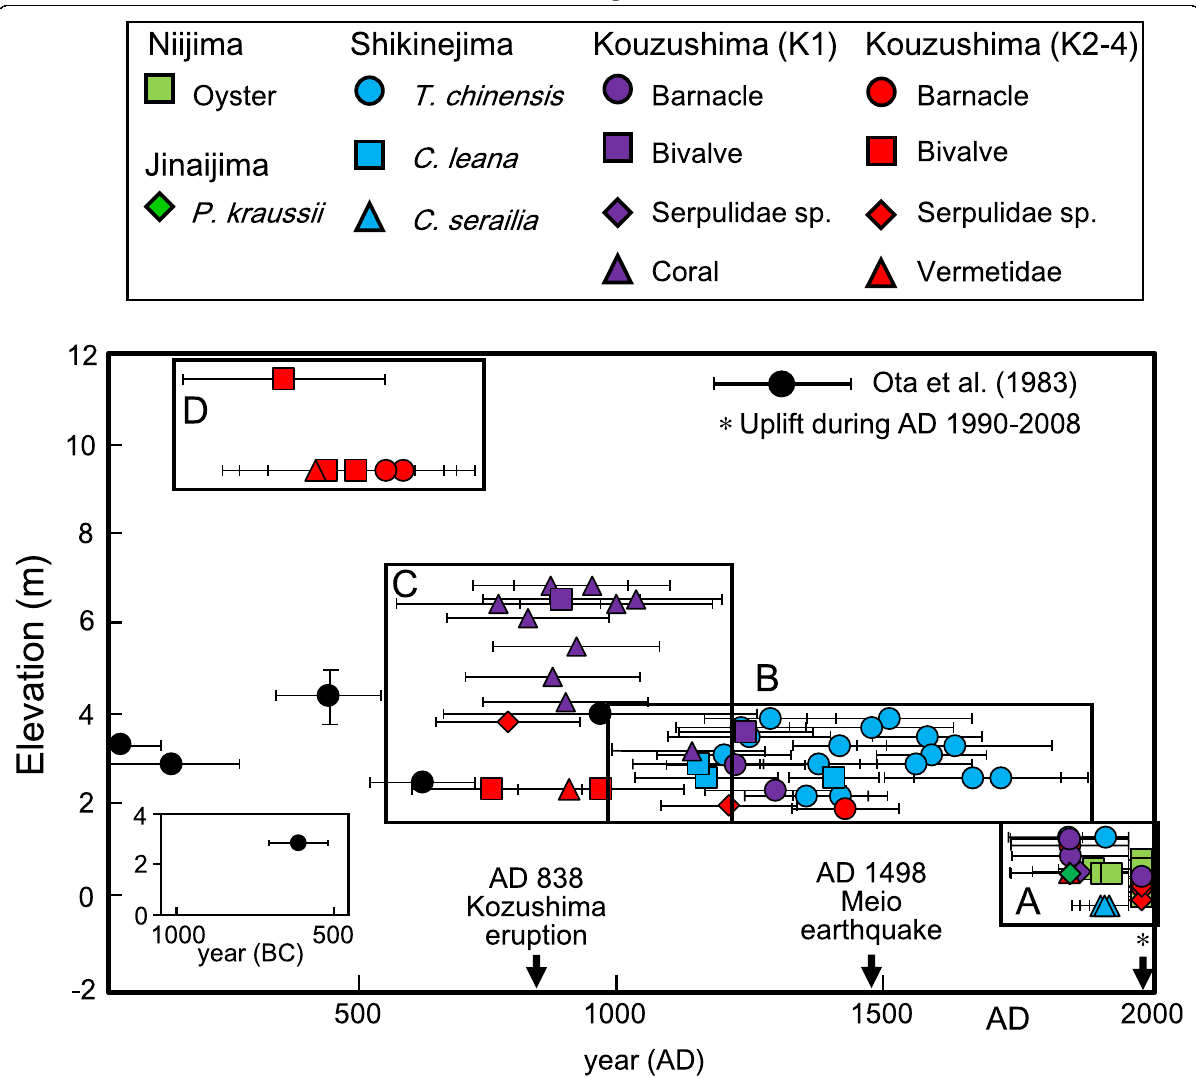
Fig. 11 Elevations and ages of emerged sessile assemblages at the study